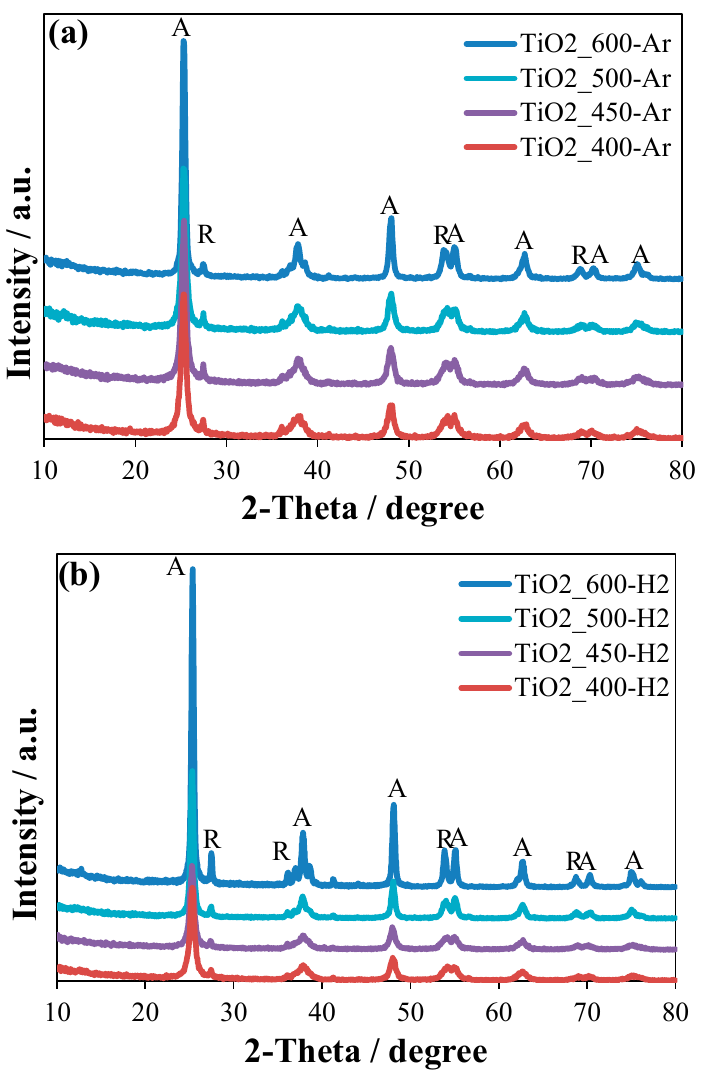
Figure 1. XRD patterns of the prepared TiO 2 samples heating at 400–600 °C under ( a ) Ar, ( b ) H 2 . Table 1. Brief characteristics of the titania samples heat-treated under H 2 and Ar.